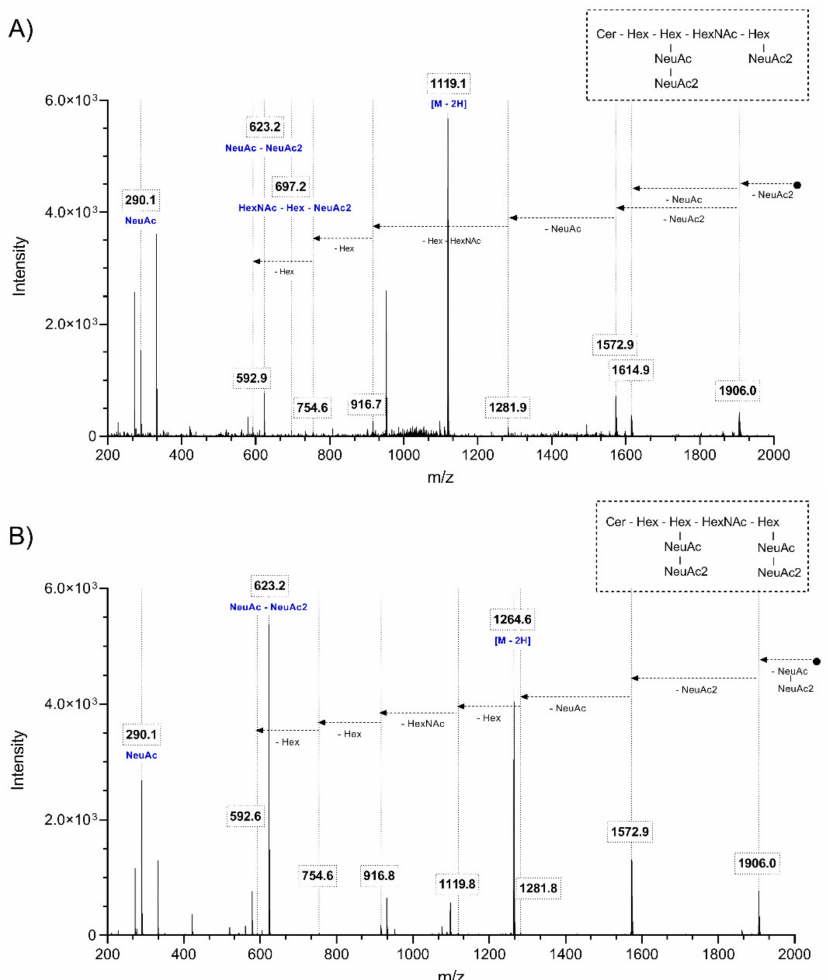
Figure 2. Fragmentation spectra of representative ganglioside species from both newly discovered ganglioside classes. LC-(ESI)-MS/MS spectra were obtained for the [M-H] 2 − ion of GT1b-Ac2 at m / z 1119.1 ( A ), and the [M-3H] 3- ion of GQ1b-Ac2 at m / z 842.7 ( B ) in negative ion